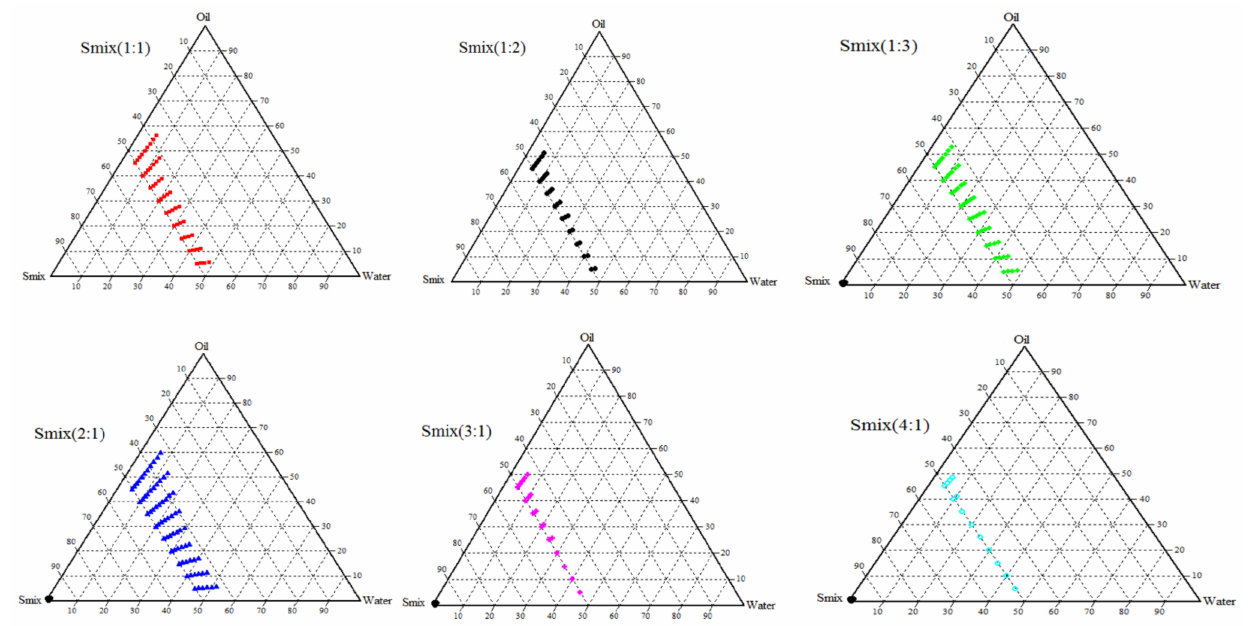
Figure 3. Ternary phase diagrams of glycerol triacetate (oil phase) to identify the nanoemulsion region (as marked by color) with different ratios of S mix (Tween 80: PEG